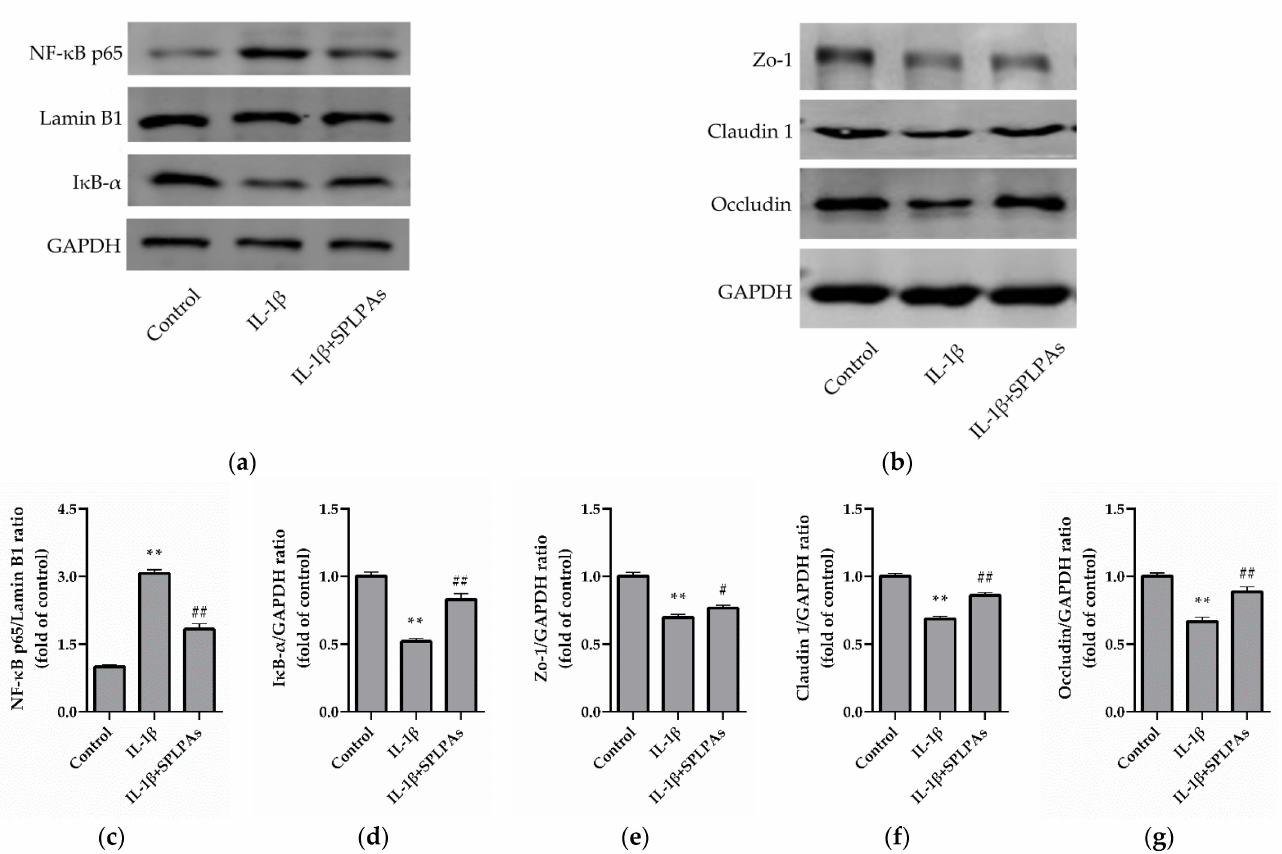
Figure 4. Effect of SPLPAs extract on the protein expression of NF- κ B and tight junctions. ( a – c ): Effect of SPLPAs extract on the protein expression of p65 in the nucleus and IKB1 in the cytoplasm. Caco-2 cells were treated with 1 for 48 h after IL-1 β stimulation, and the protein level was visualized and quantified by Western blotting. ( d – g ): Effect of SPLPAs extract on the expression of Zo-1, Claudin 1 and Occludin in Caco-2 monolayers. Caco-2 cells were treated with 1 for 48 h after IL-1 β stimulation, and the protein level was visualized and quantified by Western blotting. ** p < 0.01 vs. the control group. # p < 0.05 and ## p < 0.01 vs. the IL-1 β (10 ng/mL) group. Tight junctions are integral components of the intestinal barrier, and dysregulation SPLPAs extract may regulate the tight junction proteins, the protein levels of tight junctions -related proteins ZO-1, Claudin 1 and Occludin were detected by Western blot. These results showed that SPLPAs extract treatment for 48 h significantly upregulated ZO-1, Claudin 1 and Occludin protein levels in Caco-2 cells (Figure